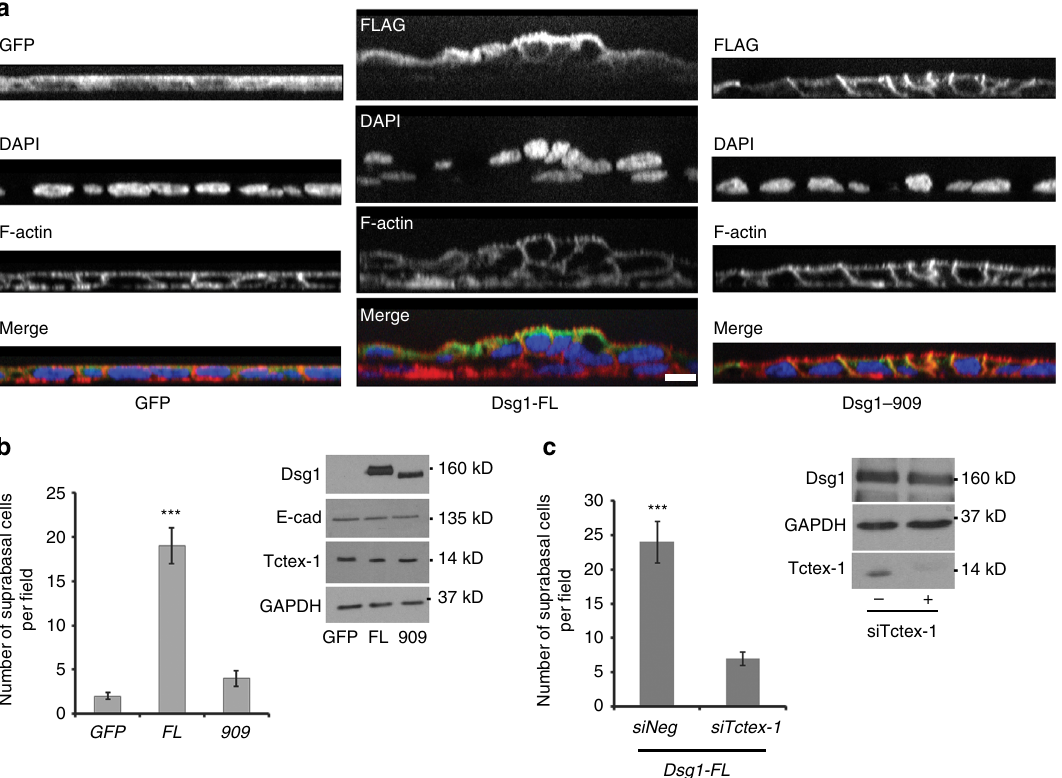
Fig. 7 Tctex-1 dependent Dsg1 localization at the cell – cell interface promotes extrusion of MDCK cells from a polarized monolayer. a X – Z scanned images of MDCK polarized monolayers expressing GFP, Dsg1-FL-Flag, or Dsg1-909-Flag. Monolayers were stained for Flag (green), F-actin (red), and DAPI